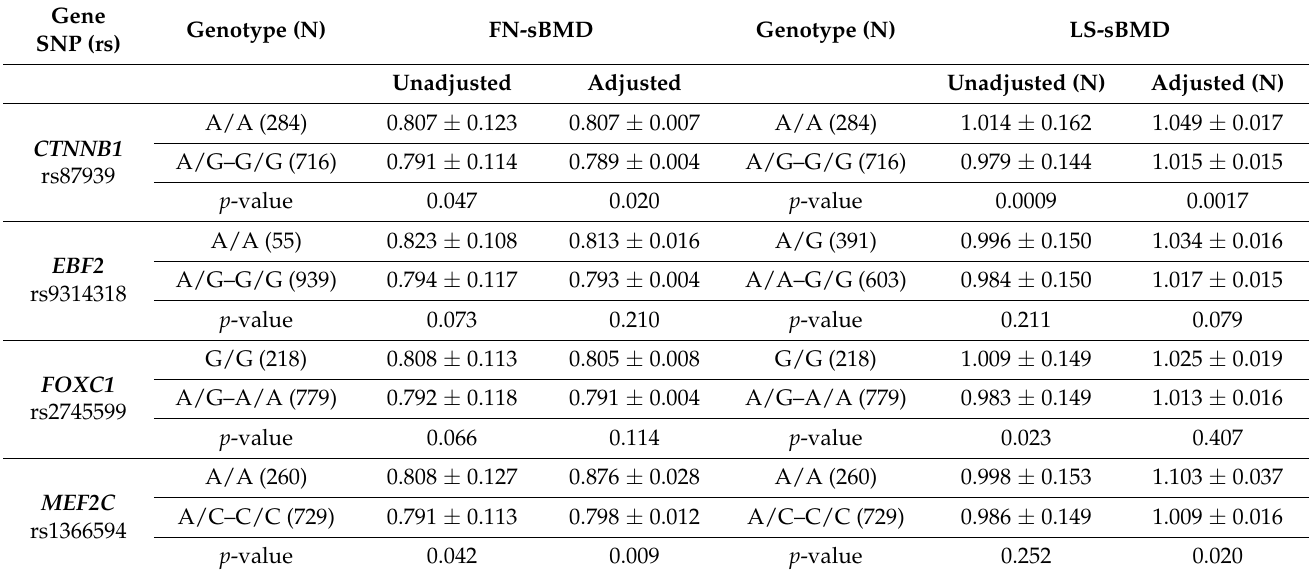
Table 3. Association of SNPs, according to the inheritance model, with FN- and LS-sBMD, with and without adjustment for age, BMI, postmenopausal status, and treatment use. Unadjusted values are means ± SD. Adjusted values are estimated means ± SE.